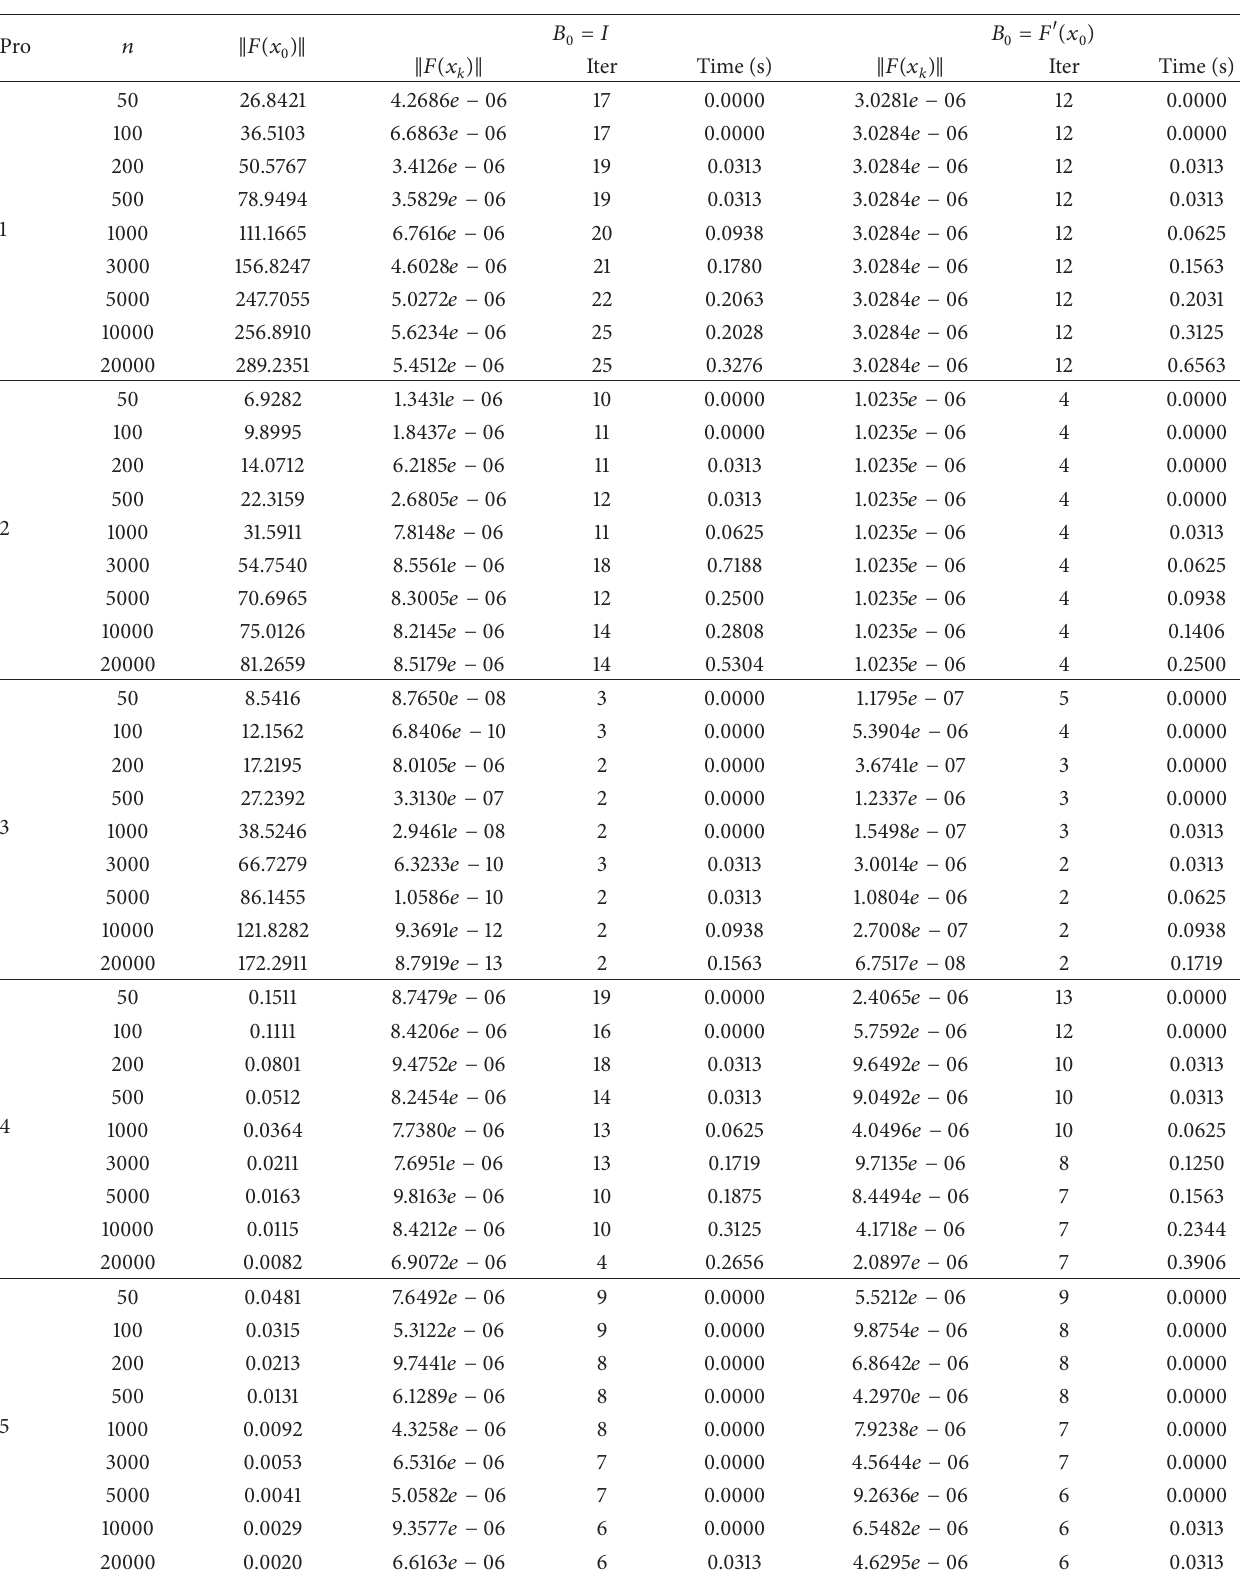
Table 1: Results of Algorithm 3 for Problems